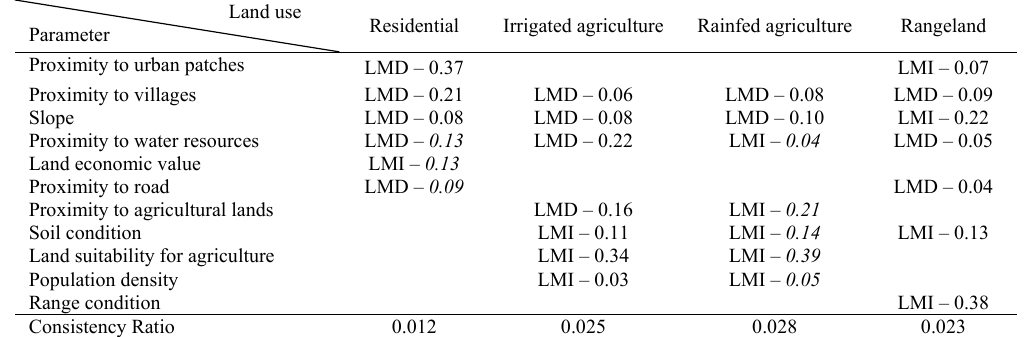
Table 2: Form of fuzzy membership function, eigenvectors of weight (values in italic) and AHP consistency ratio for each land use class